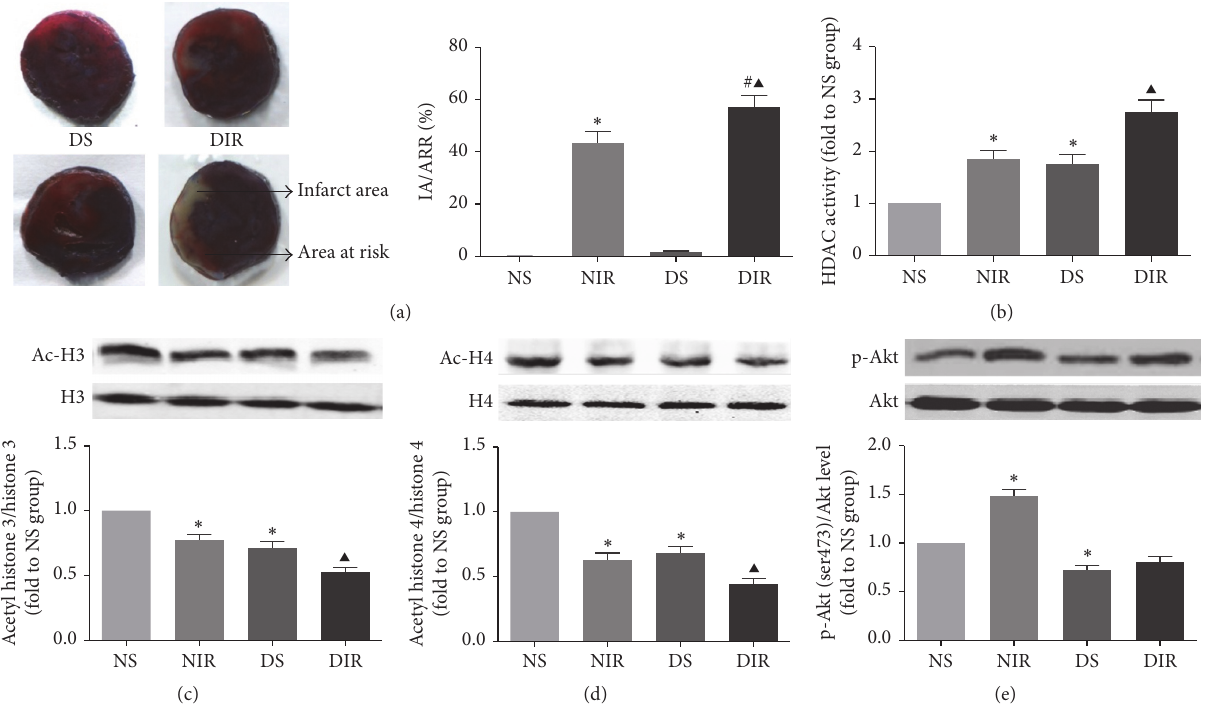
Figure 2: Myocardial infarct size and HDAC activity assessment in diabetic and normal rats. (a) Infarct area versus area at risk (IA/AAR × 100%). (b) Effect of MI/R and diabetes per se on total HDAC activity in myocardium. (c, d) Western blot analysis of myocardium acetylated histones H3 and H4 (Ac-H3, Ac-H4), with histones 3 or 4 (H3, H4) serving as the loading control. (e) p-Akt (ser473) and Akt protein expression in myocardium. All the results are presented as mean ± SEM, 𝑛 = 6 /group. ∗ 𝑝 < 0.05 versus NS group. 󳵳 𝑝 < 0.05 versus DS group. # 𝑝 < 0.05 versus NIR